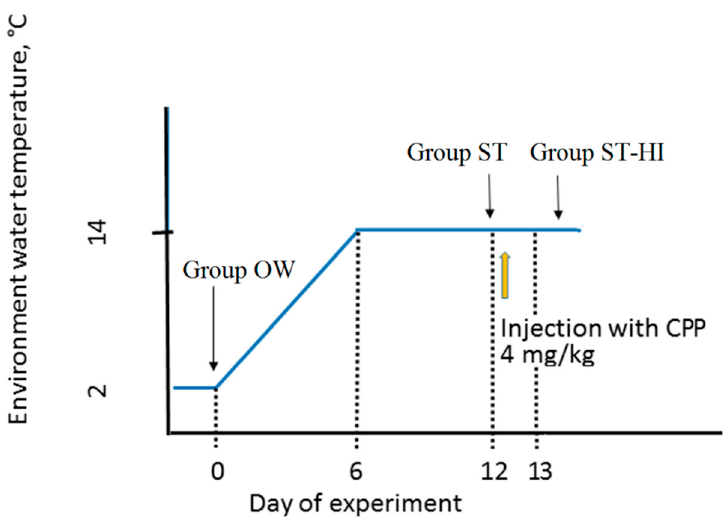
Figure 1. Temperature regime and hormonal injection timing for experimental fish groups. Group OW—fish after overwintering; group ST—fish adapted to spawning temperature; and group ST-HI—fish adapted to spawning temperature with hormonal induction of spermiation by carp pituitary powder (CPP).